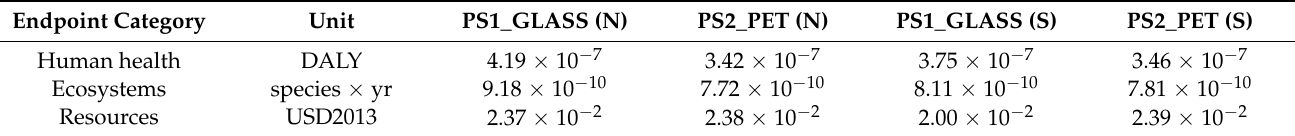
Table 6. Potential environmental impacts of the considered packaging systems for natural (N) and sparkling (S) drinking water estimated with the endpoint categories of ReCiPe